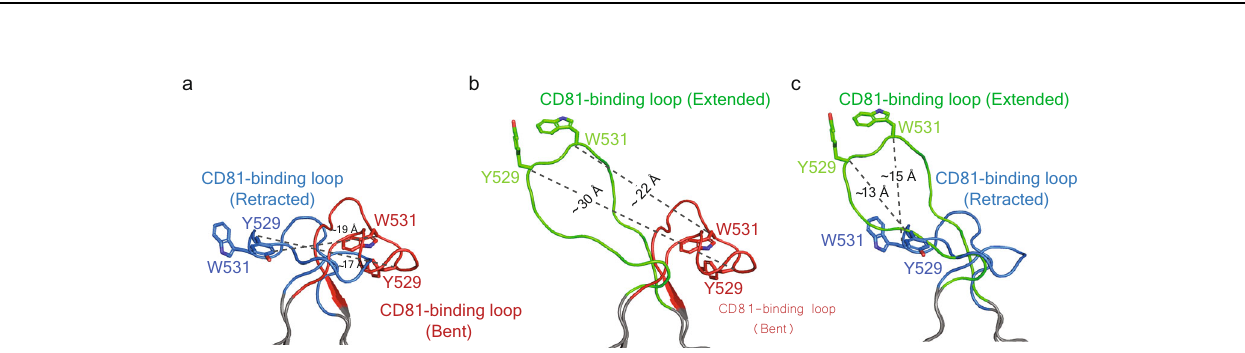
loop of Δ HVR1 eE2 (green) and retracted CD81-binding loop of eE2 (blue). b , c tCD81-LEL bound to Δ HVR1 eE2 (green) is not shown. Adjacent backbone residues are gray. The location of Y529 and W531 side chains are shown as het- eroatom sticks, and the distances are